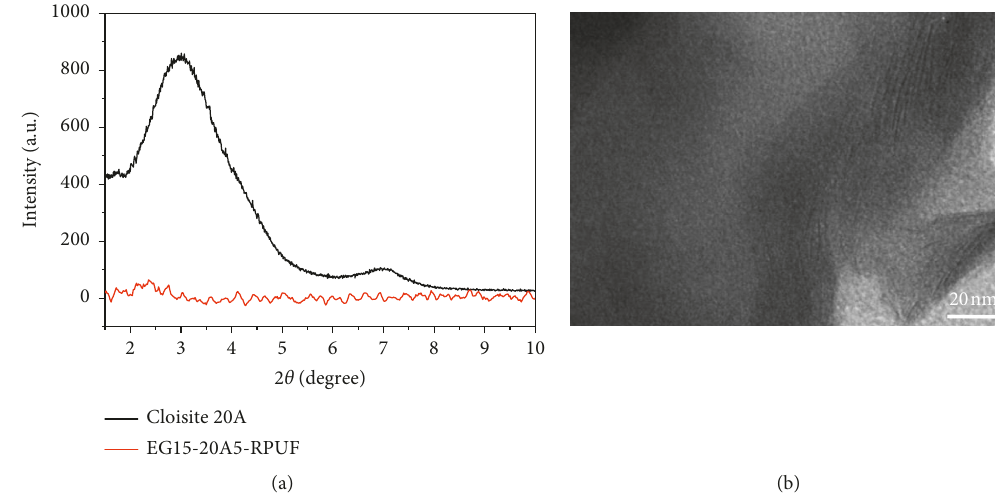
Figure 6: XRD patterns of clay and the RPUF composite (a) and TEM micrograph of EG15-20A5-RPUF composite (b).